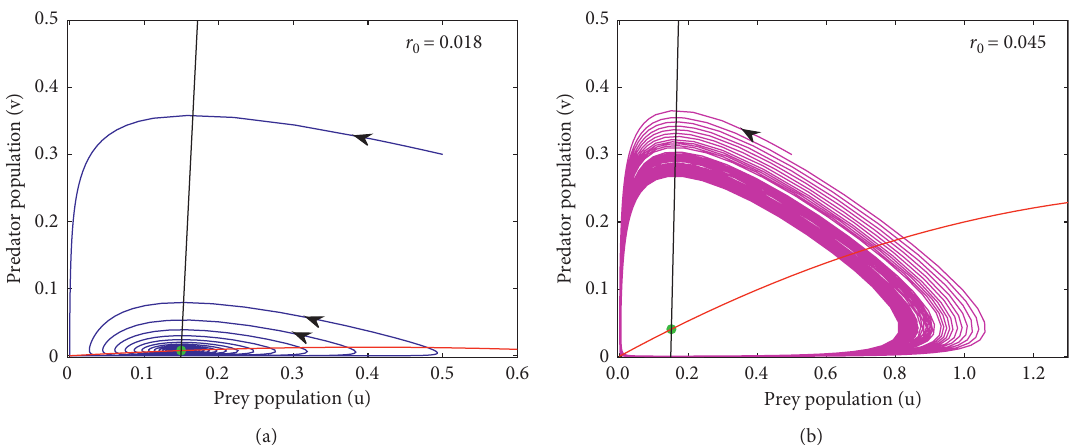
Figure 8: Phase portrait diagram of the predator-prey system (19) with Beddington–DeAngelis-type response function at the coexisting singular point E ∗ (green filled circle) with initial values [ x ( 0 ) , y ( 0 )] � [ 0 . 5 , 0 . 3 ] . Black line is the predator isocline, and the red curve is the � 0 . 018; (b) r � 0 . 045, and rest of the parameters are specified as δ prey isocline. (a) r 0 0 and ξ � 0 . 30.